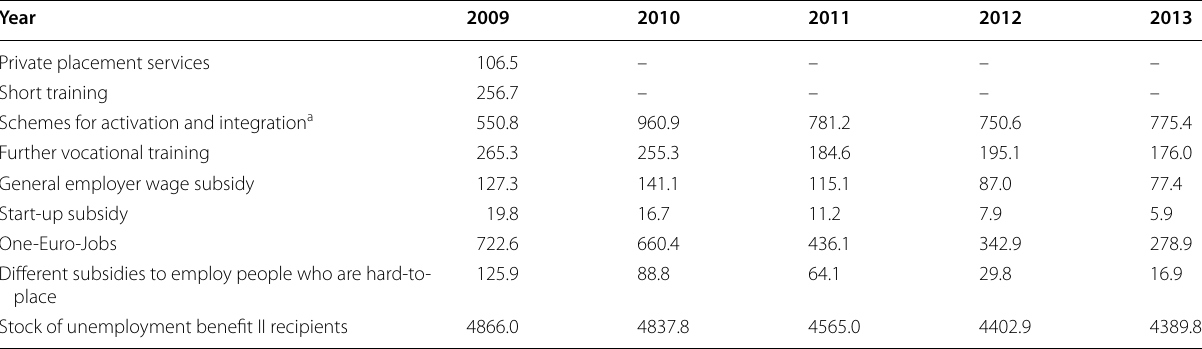
a This ALMP was introduced in 2009 to replace the private placement services and short training